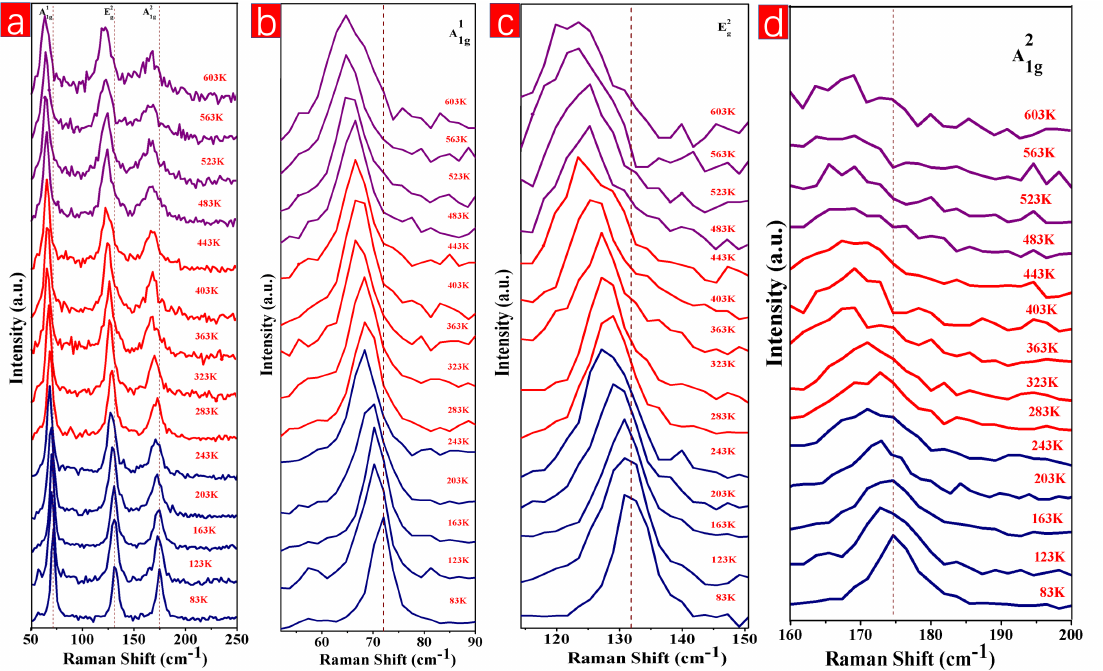
Figure 3. ( a ) Raman spectra of Bi 2 Se 3 single crystal in the temperature range of 83–603 K. ( b – d ) A 1 E 2 g , and A 2 modes of Raman spectra in the temperature range of 83–603 1 g